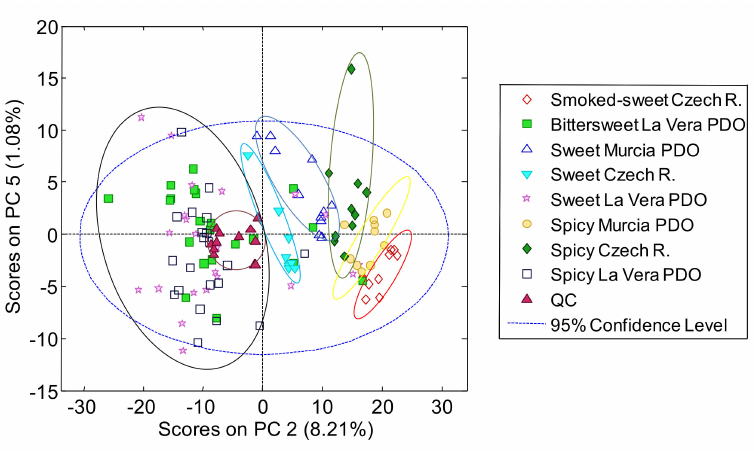
Figure 2. Principal component analysis (PCA) score plot of PC2 vs. PC5 when using the UHPLC-HRMS polyphenolic profiles as paprika sample chemical